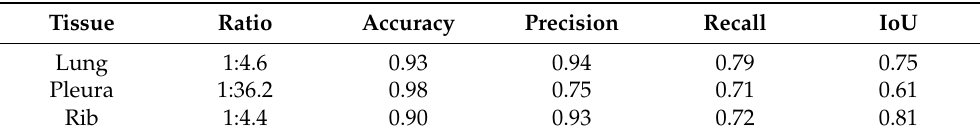
Table 1. Average performance of U-Net in binary segmentation of the lung, pleura, and rib. (Ratio: Target class:background; Acc.: Accuracy; IoU: Intersection over